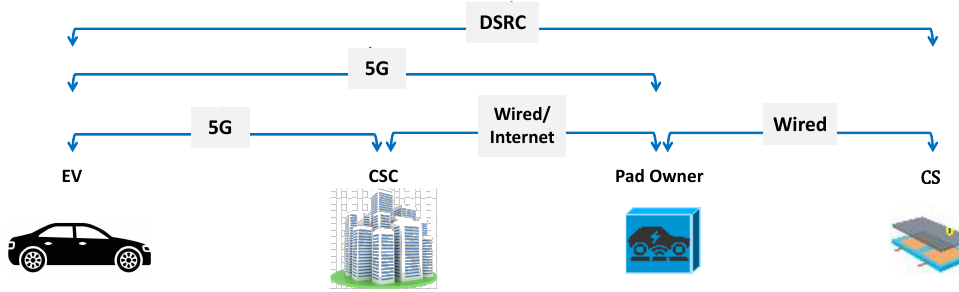
Figure 3. Overview of the different communication technologies utilized in the proposed model.